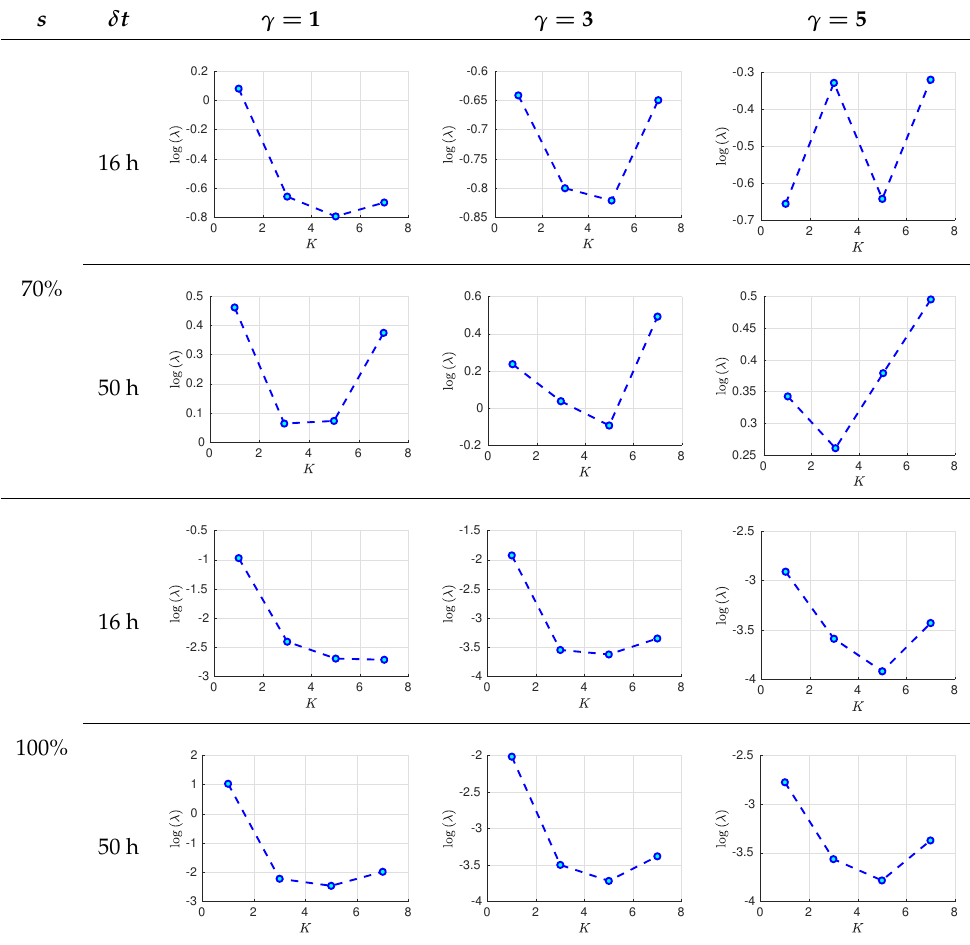
Table 1. Experimental results with the Lorenz-96 model. Mean of RMSE values are reported across the 10 different experimental configurations for different configuration of parameters δ t , s , K , and γ . The number of ensemble members equals N =